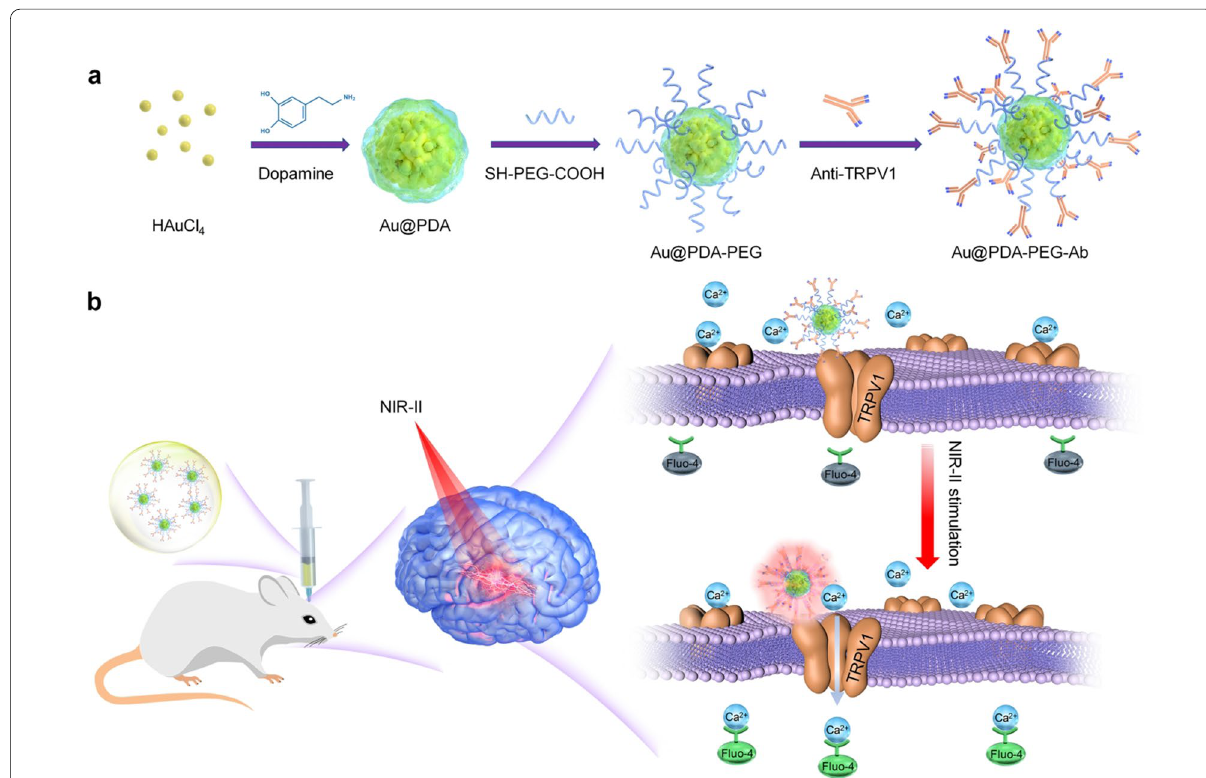
Fig. 1 Scheme of NIR-II neural stimulation via targeted Au nanoparticles. a Preparation of antibody-conjugated gold nanoparticles. b Mechanisms of nanoparticle-mediated NIR-II neural